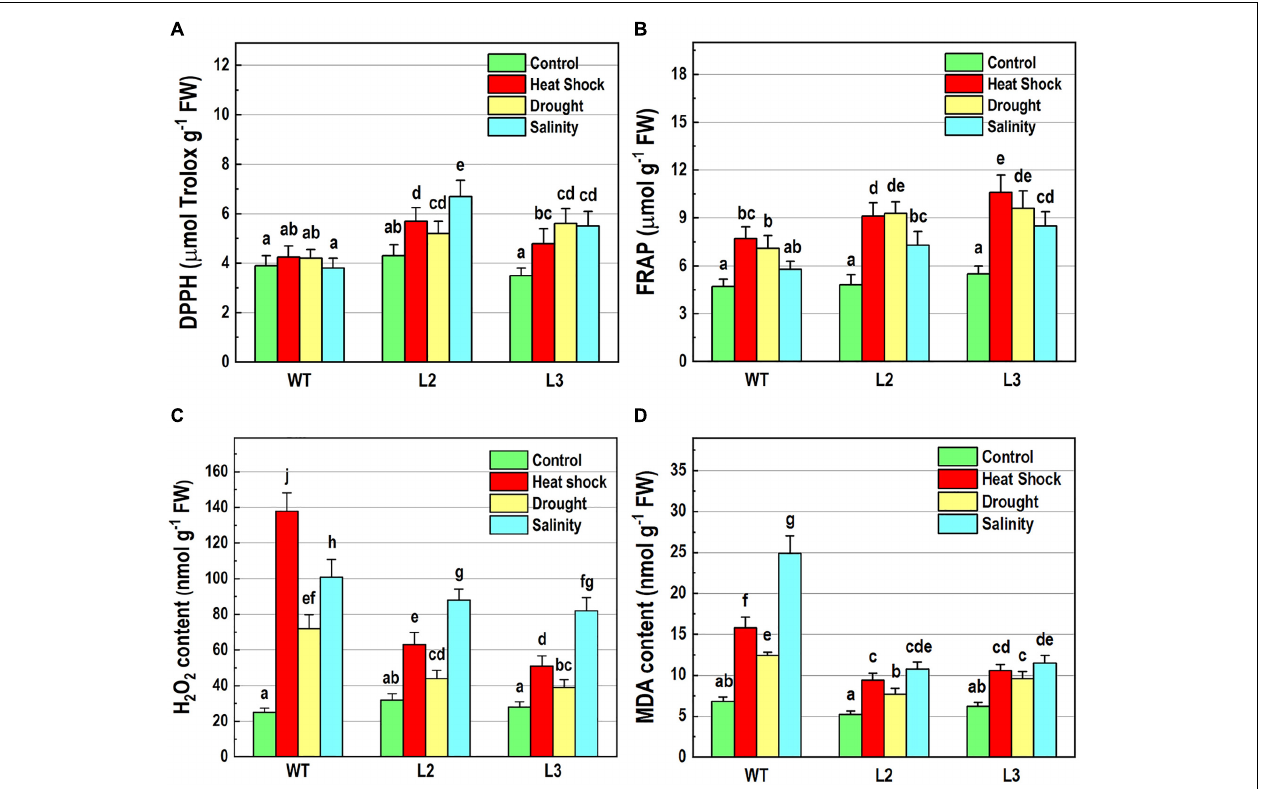
FIGURE 6 | Determination of antioxidant-related parameters in 10-day-old wild-type seedlings and transgenic lines overexpressing NMig1 (L2 and L3) after exposure to heat shock, drought and high salinity: (A) free radical scavenging activity, (B) antioxidant capacity, (C) hydrogen peroxide (H 2 O 2 ) content, and (D) malondialdehyde (MDA) level. Different lowercase letters indicate statistically significant difference ( p ≤